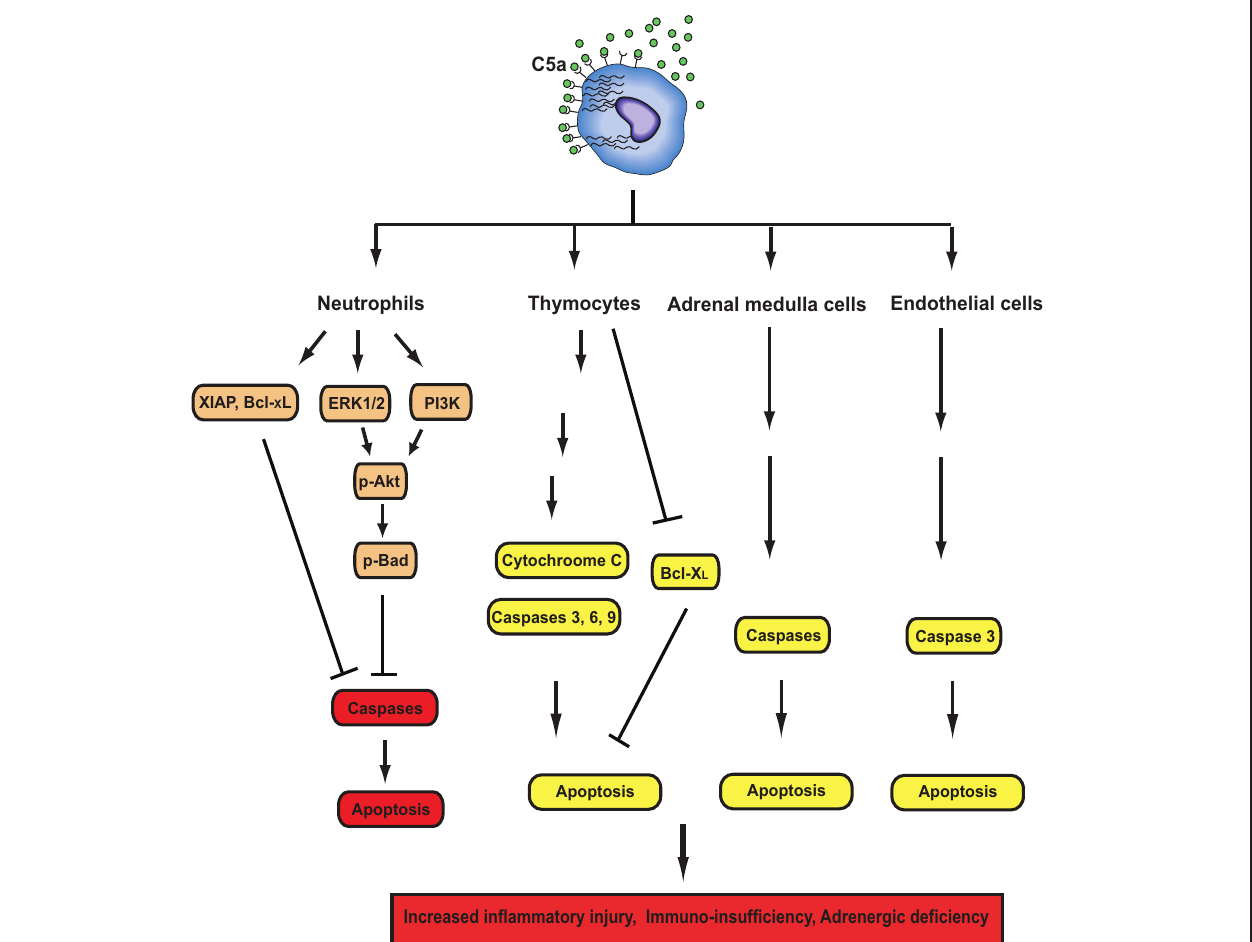
FIGURE 2 | Effects of C5a signals on apoptosis during sepsis. C5a have both anti- and pro-apoptotic activities depending on cell types. In neutrophils, C5a activates PI3K and ERK1/2 pathways, leading to phosphorylation of Akt and subsequent phosphorylation of Bad. Phosphorylated Bad